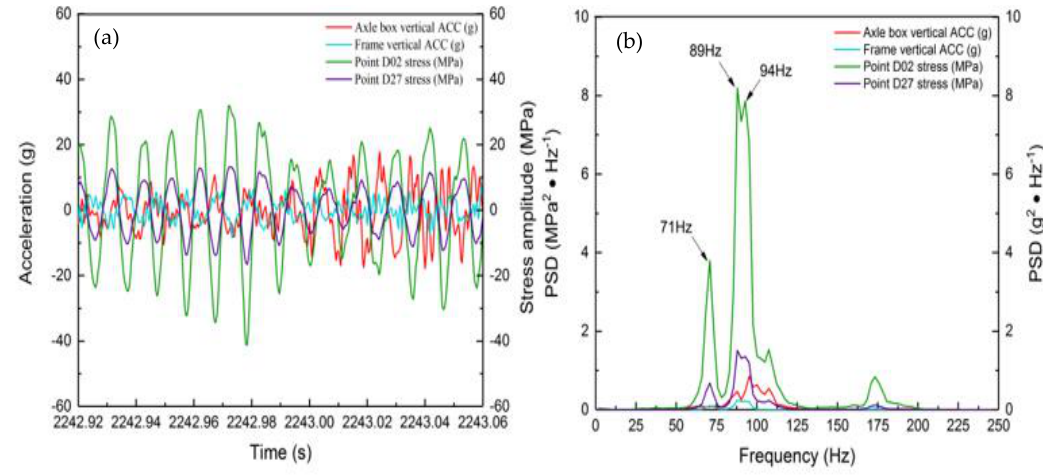
Figure 11. Relationship between the vibration acceleration and stress response: ( a ) time domain diagram; ( b ) power spectrum diagram.